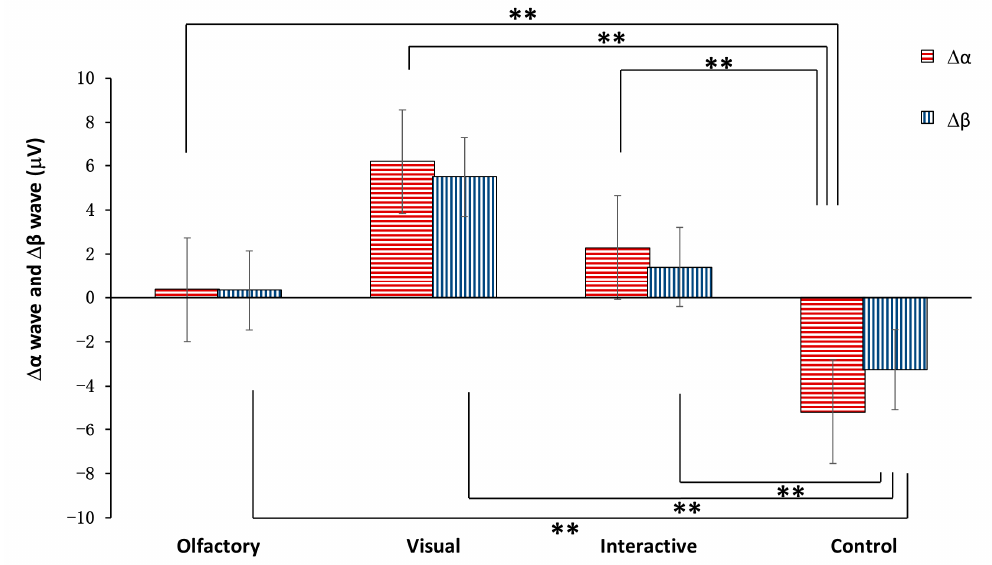
Figure 5. Effects of different stimulation types on the amplitudes of α and β brainwaves. ** indicates that the difference between the two was extremely significant, p < 0.01; * indicates a signifi- cant difference between the two, 0.01 < p < 0.05.